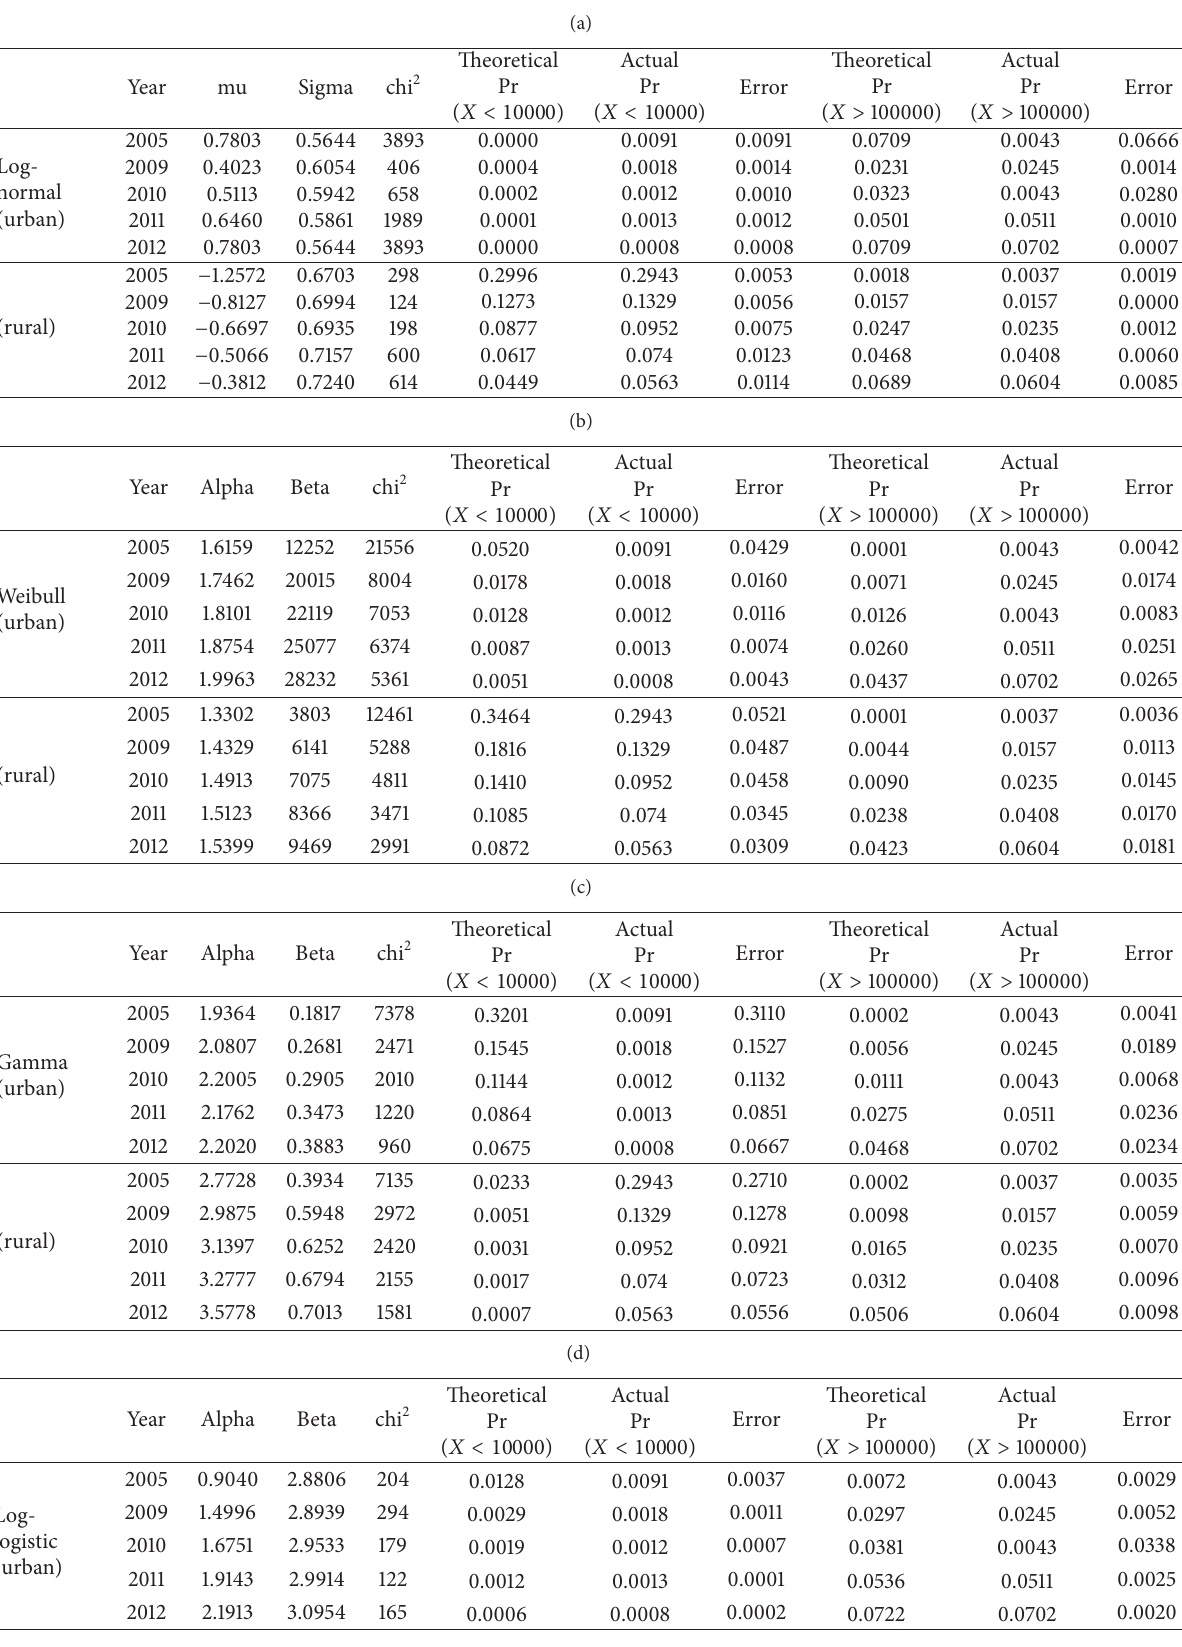
Table 1: Fitting results of the eight distribution